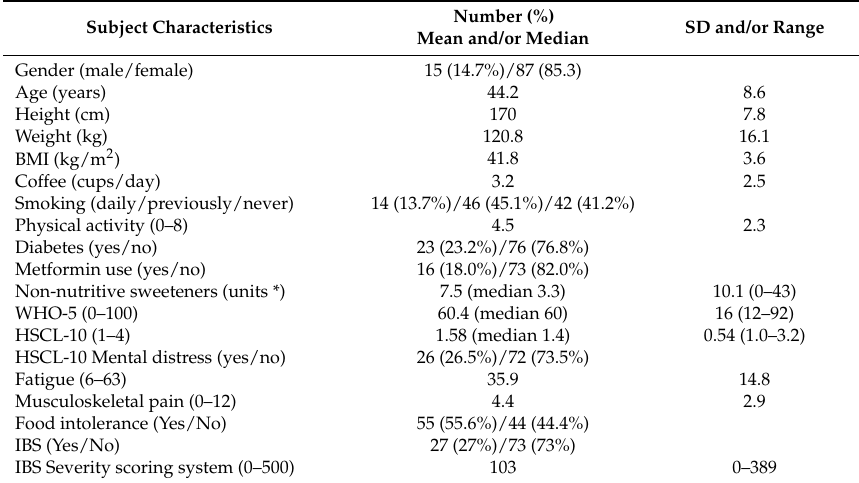
Table 1. Subject